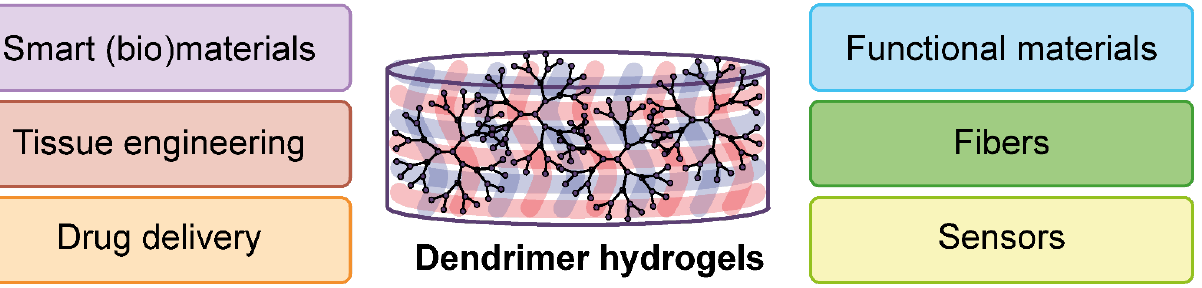
Figure 16. Already observed properties of physical hydrogels based on dendritic molecules.